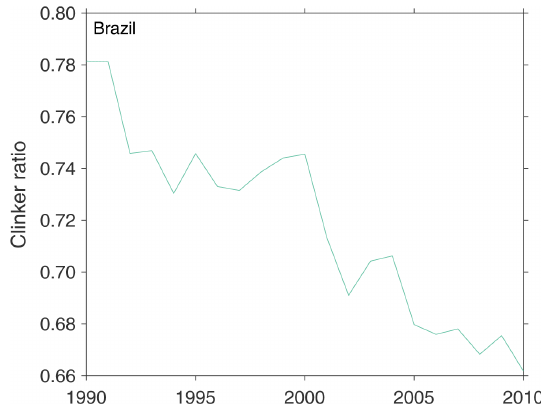
Figure C16. Brazil’s approximate clinker ratio, with no account for clinker